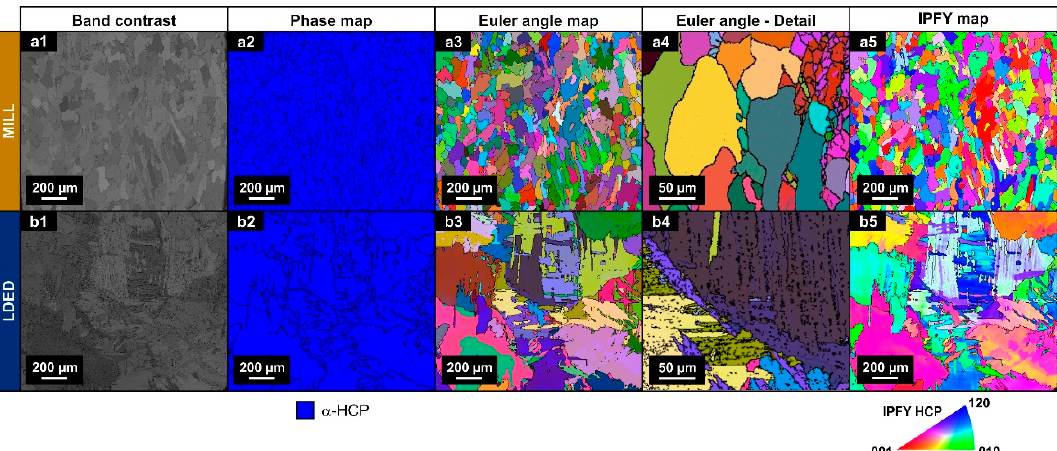
Figure 6. EBSD images of band contrast ( a1,b1 ), phase maps ( a2,b2 ), Euler color maps ( a3,b3,a4,b4 ) and IPFY maps ( a5,b5 ) for both MILL ( a1–a5 ) and LDED ( b1–b5 ) materials.